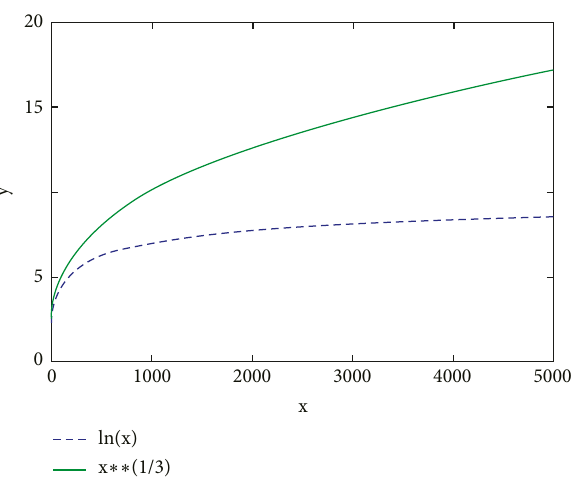
Figure 9: Cube root compression and logarithmic